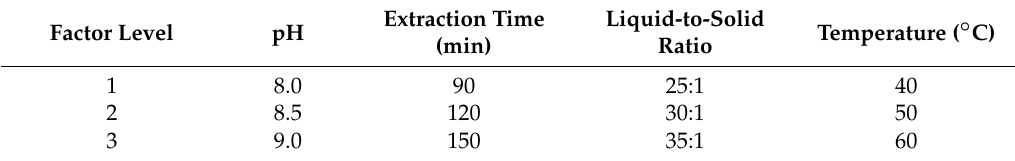
Table 3. Factors and levels for orthogonal